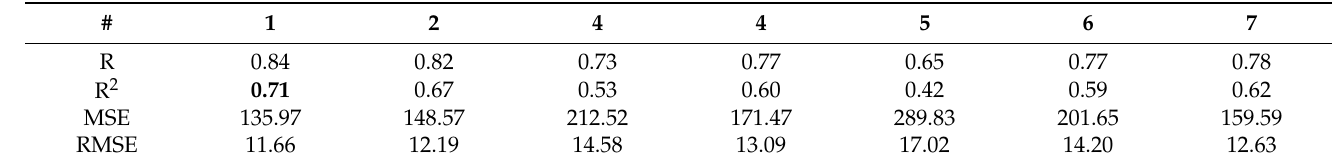
Table 6. Summary of multi-variable statistical analysis of database using linear functions. Statistical indices (#).